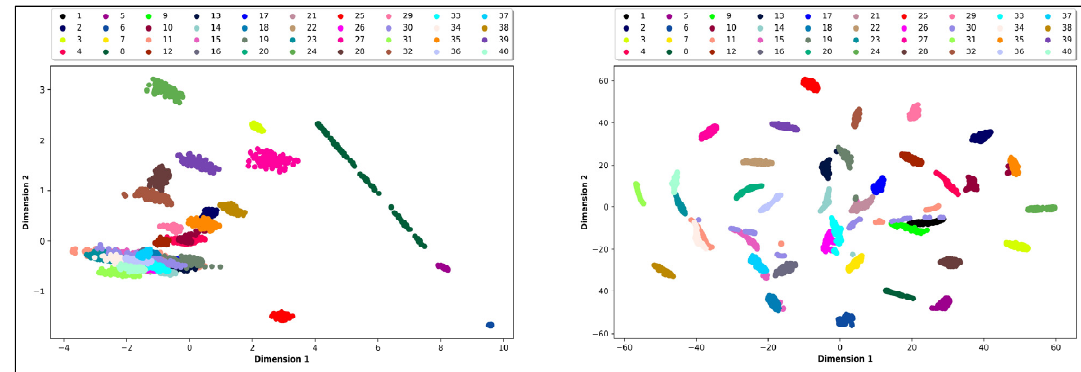
Figure 6. Clustering results of 40 paper samples, with a sample size of 100 spectra. Left-hand plot is obtained using Principal Component Analysis (PCA), and the right-hand plot is obtained using t-Distributed Stochastic Neighbor Embedding (t-SNE).